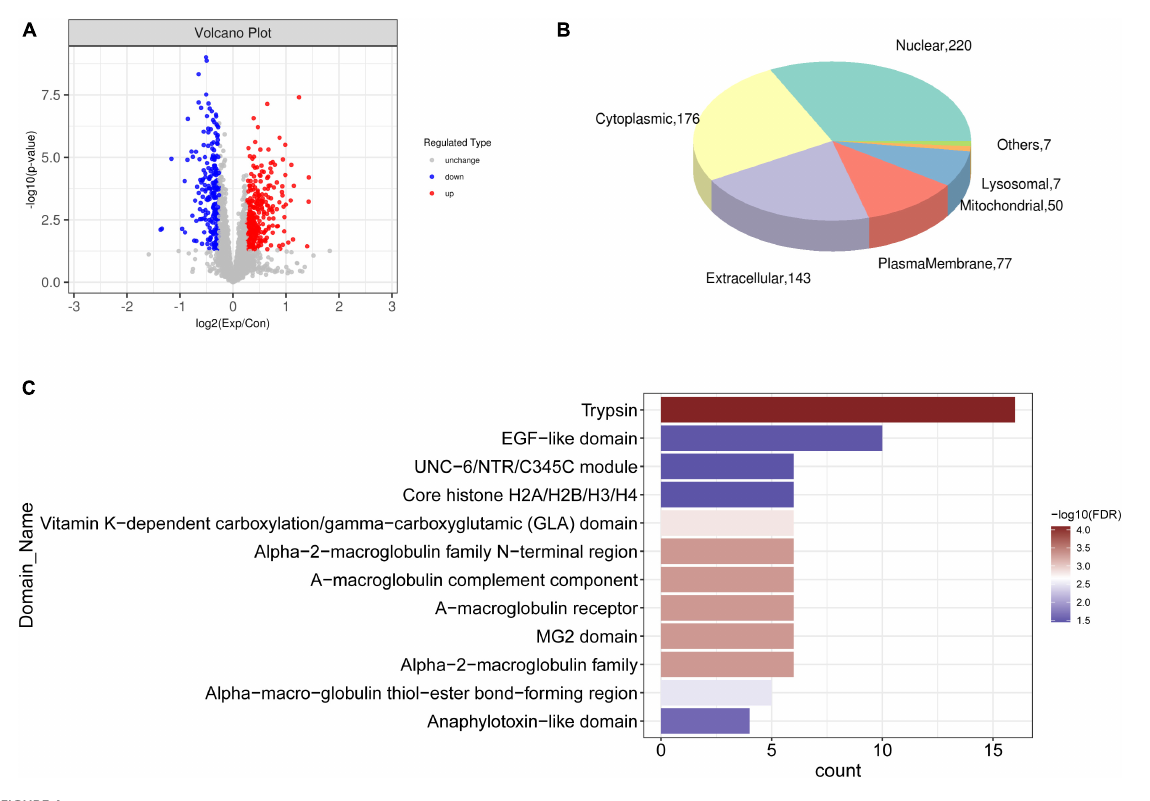
FIGURE4 Differentially expressed proteins. (A) Volcano plot of differentially expressed proteins between CAVD and controls; blue and red dots, downregulated and upregulated proteins, respectively. (B) Pie chart of subcellular localization of differential proteins. (C) Significantly enriched domains of differential